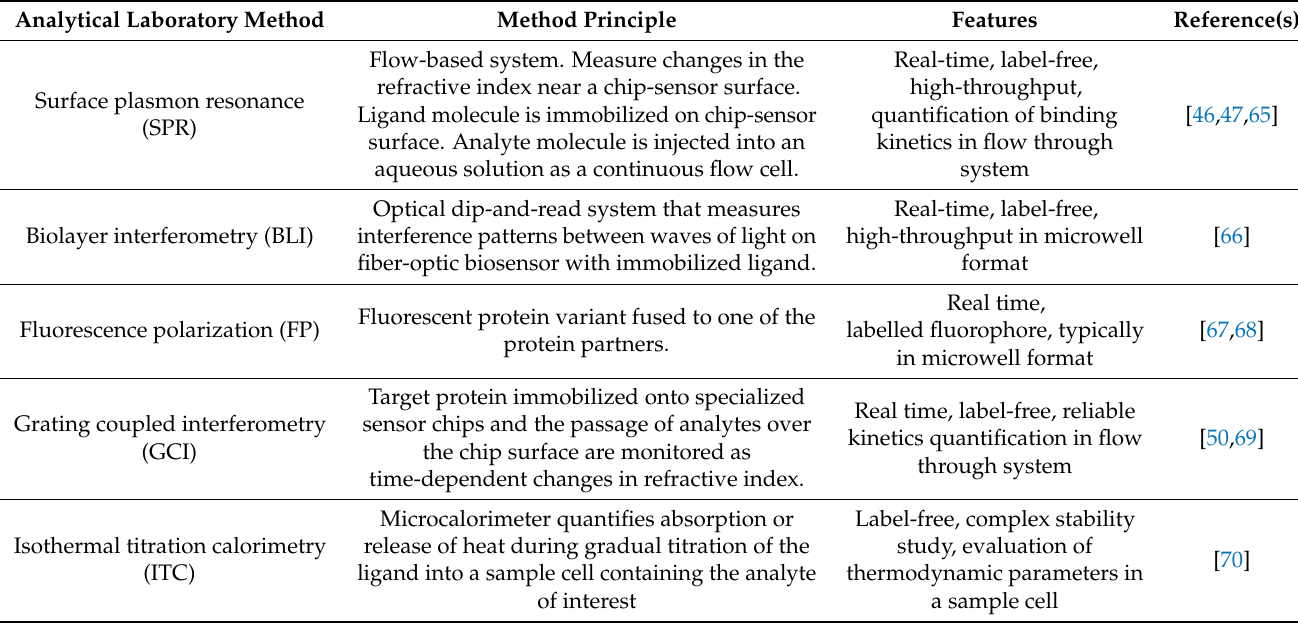
Table 1. Comparisonofanalyticalexperimentalmethodsfor characterizationofligand-analyteinteractions. Analytical Laboratory